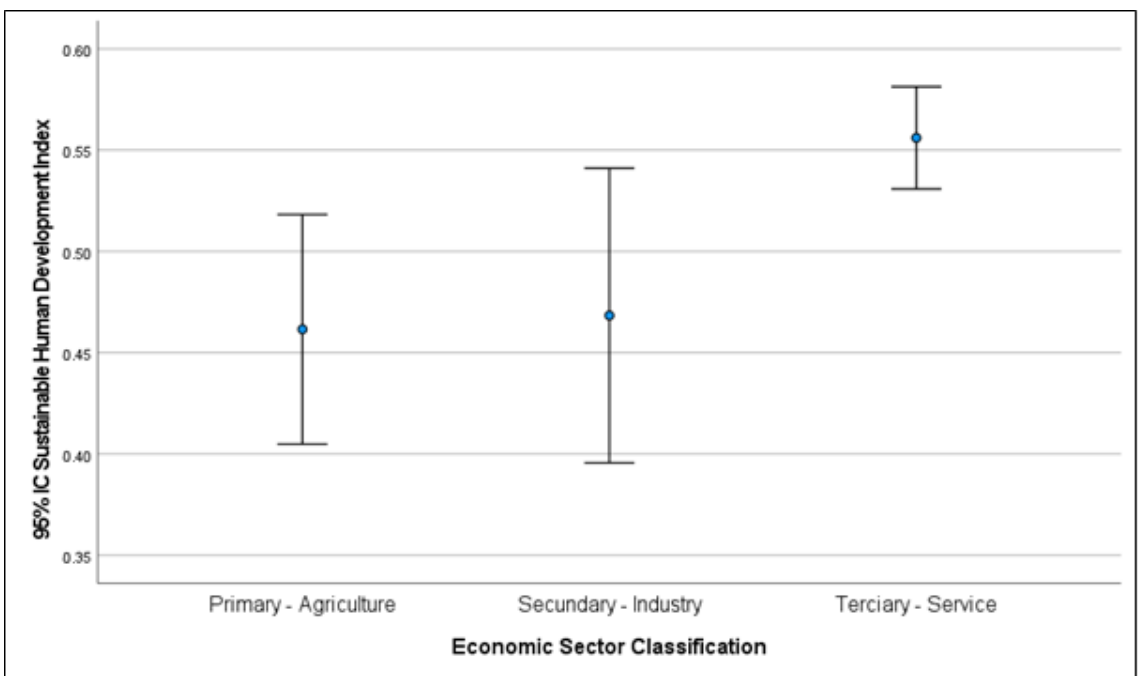
Figure 11. Error bar graph of the municipalities by sectoral economic participation.